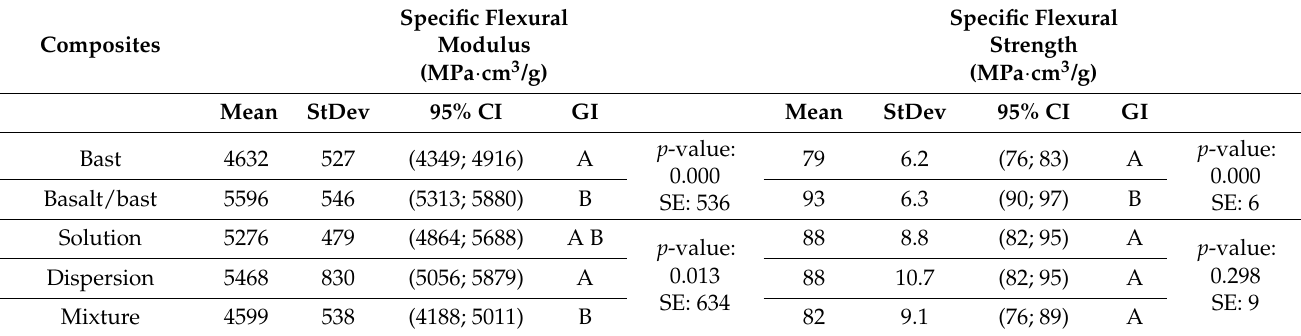
Table 6. Comparison of the means equality using one way analysis of variance—specific flexural analysis.